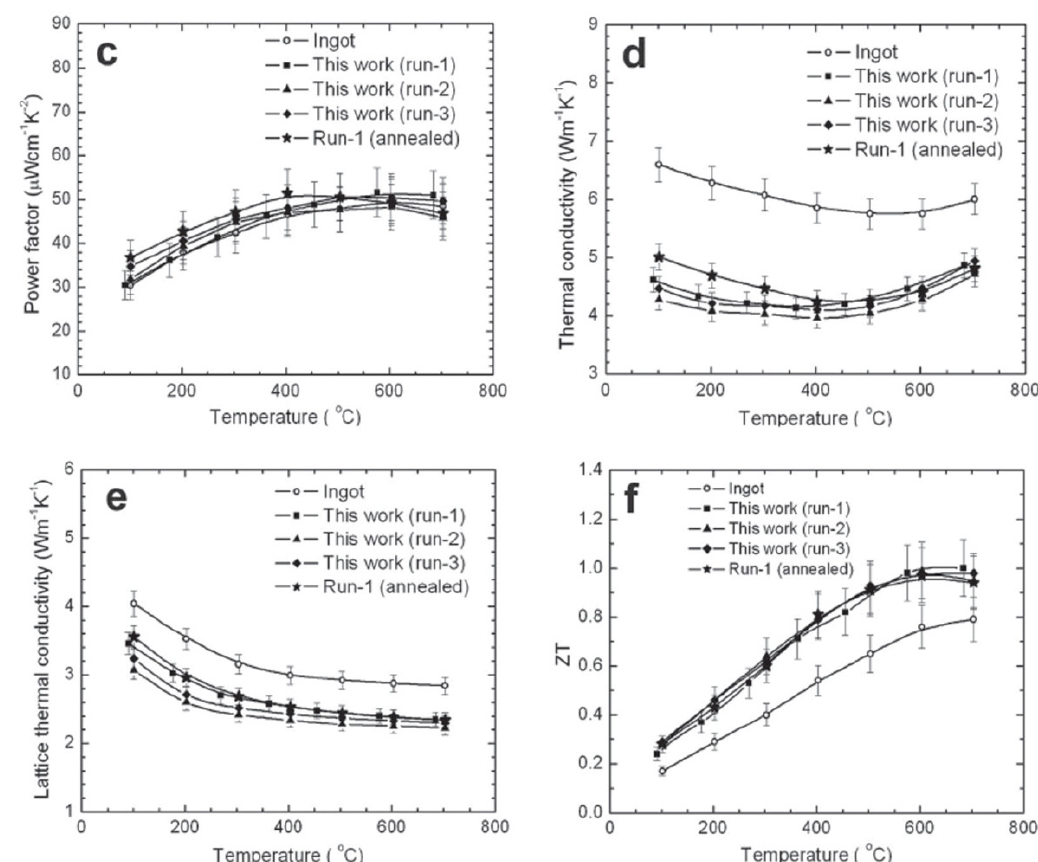
Hf NiSn. Reproduced with permission from 0.5 0.5